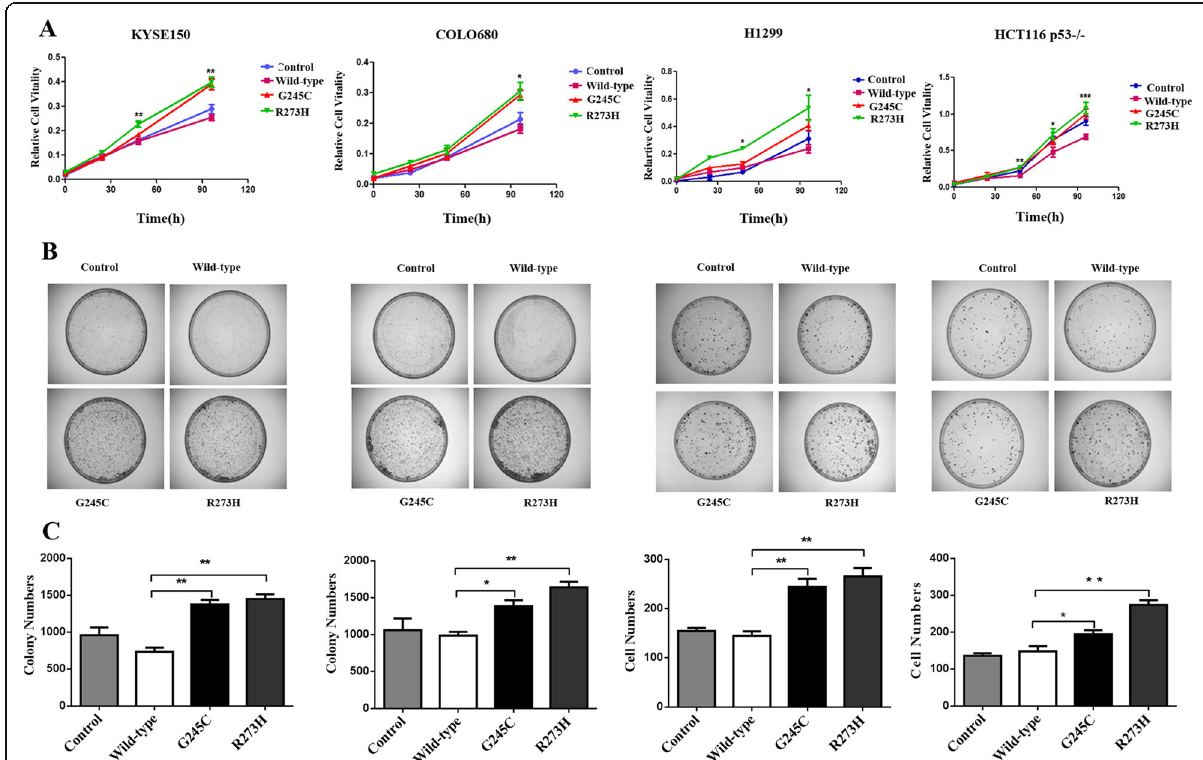
Fig. 2 TP53 G245C and R273H mutants accelerated the proliferation activities of tumor cells. a Cell proliferation activity was examined by MTS assay and each cell clusters were counted at 0 h, 24 h, 48 h, 72 h and 96 h. Data was shown as the average from at least three independent experiments. b The long-term cell growth activity was tested by colony formation assay in above four tumor cell lines. Cell numbers were counted after 14 days incubation. (* P < 0.05, ** P < 0.01, *** P <